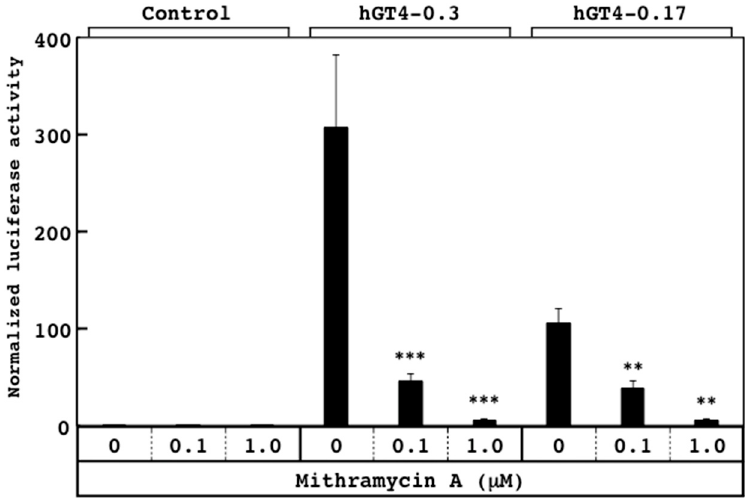
Figure 3. Effects of mithramycin A on the promoter activities of the hGT4-0.3- and hGT4-0.17-sensor cells. The luciferase activity of the control cells was set at 1.0. Data show means ± S.D. **, p < 0.01 and ***, p < 0.001 against control.